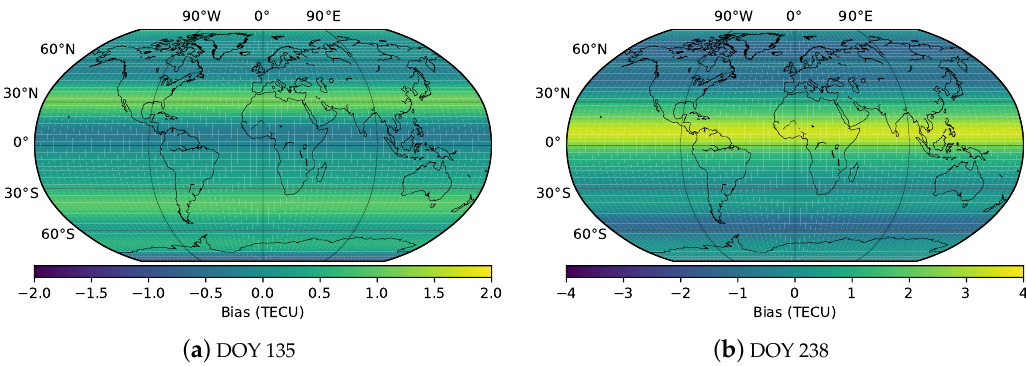
Figure 12. Bias of different latitudes at 12:00 UT on DOY 135 ( a ) and DOY 238 ( b ), 2018.